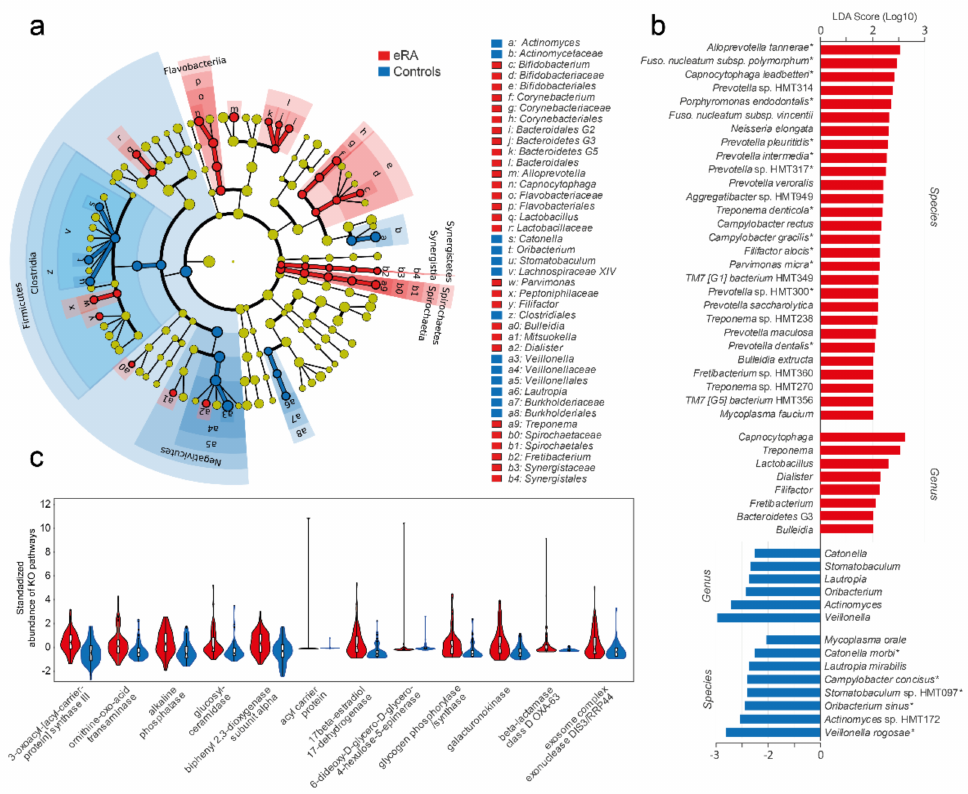
Figure 3. Bacteria (LEfSe) and predicted functions in early onset RA versus healthy subjects. ( a ) Clado- gram based on the phylum, class, order, family, genus and species abundances of the 340 bacterial species. ( b ) Bar graph showing species and genera with an LDA score > 2.0. A star (*) by the species indicates that it was detected as influential in the OPLS-DA model too (Figure 2c). ( c ) Violin plots with internal box plots of predicted upregulated microbiota functions in early-onset RA